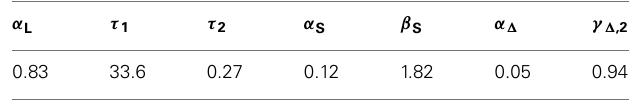
Table 3 |The optimized model parameters.